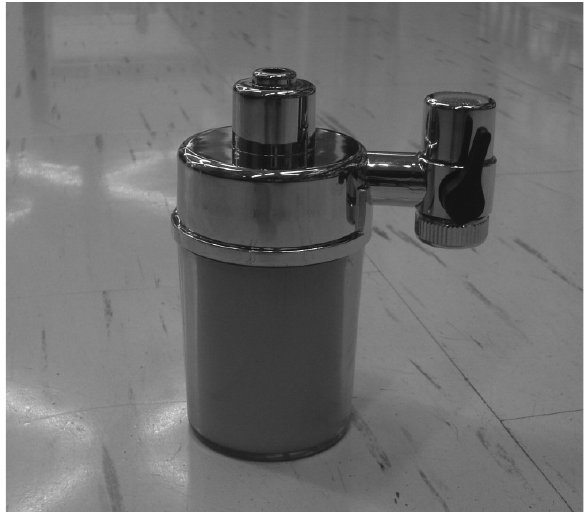
Mini tap filter – a point-of-use water-treatment device – which was used to collect